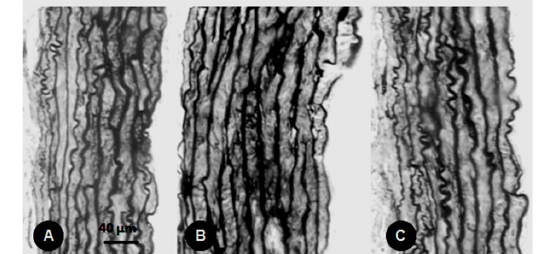
Figure 4. Photomicrographs of the ascending aorta cross-sections showing elastic lamellae (Verhöff stain). The number and thickness of elastic lamellae (arrows) in OC group (B) was greater than in MA (A) and OT (C) groups. The endothelium is on the right side.